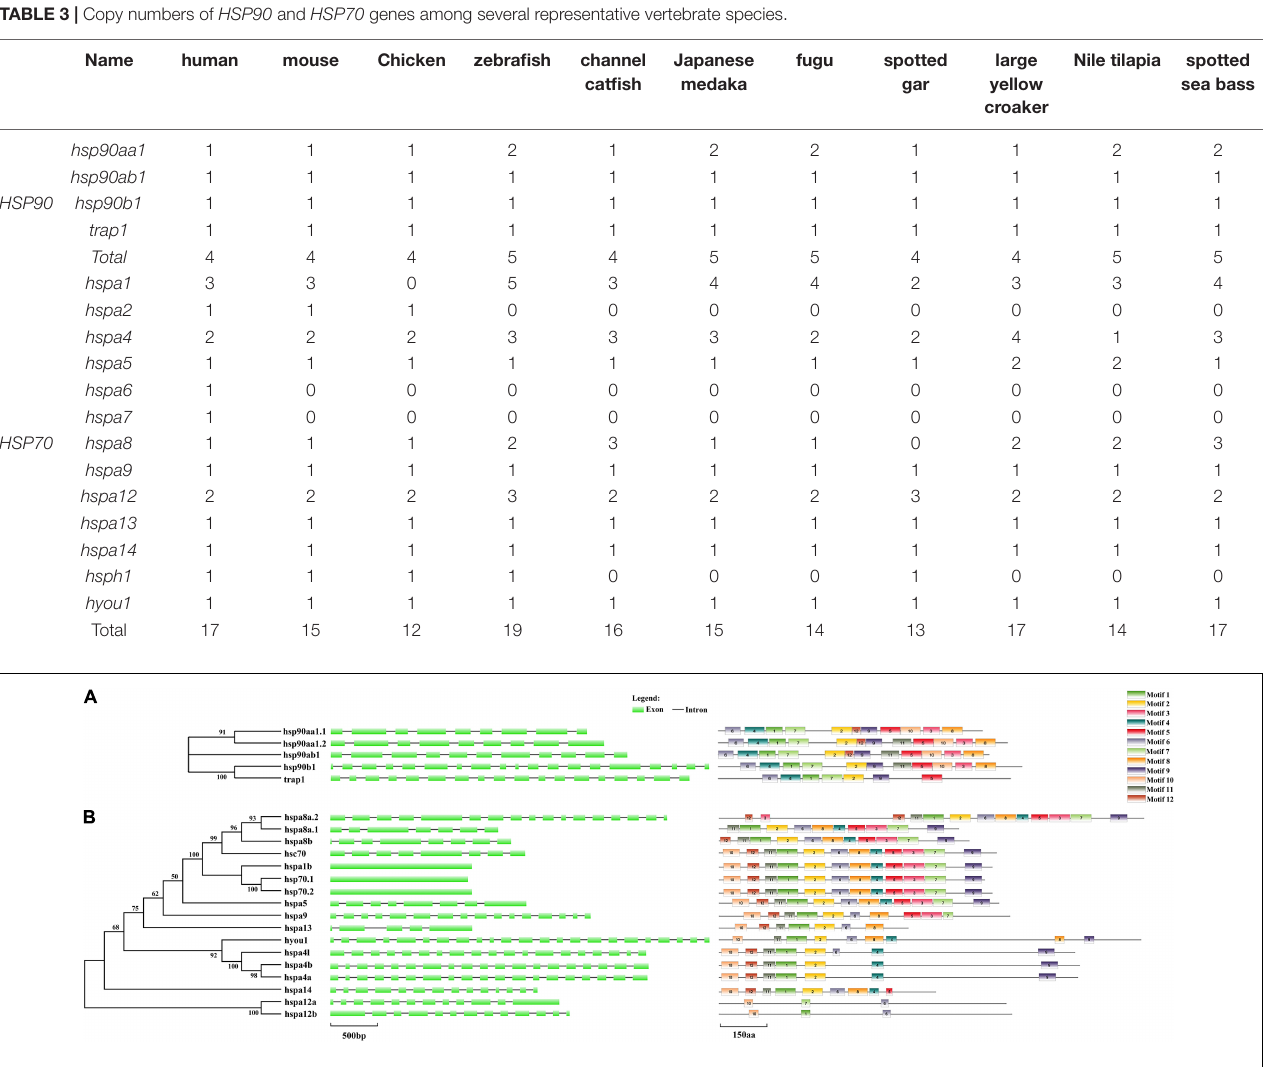
FIGURE 4 | Exon-intron structure and motif analyses of (A) HSP90 and (B) HSP70 in spotted seabass. Exons were shown by green rectangles and introns were indicated by black lines. Lengths of exons and introns are displayed proportionally according to the scale.